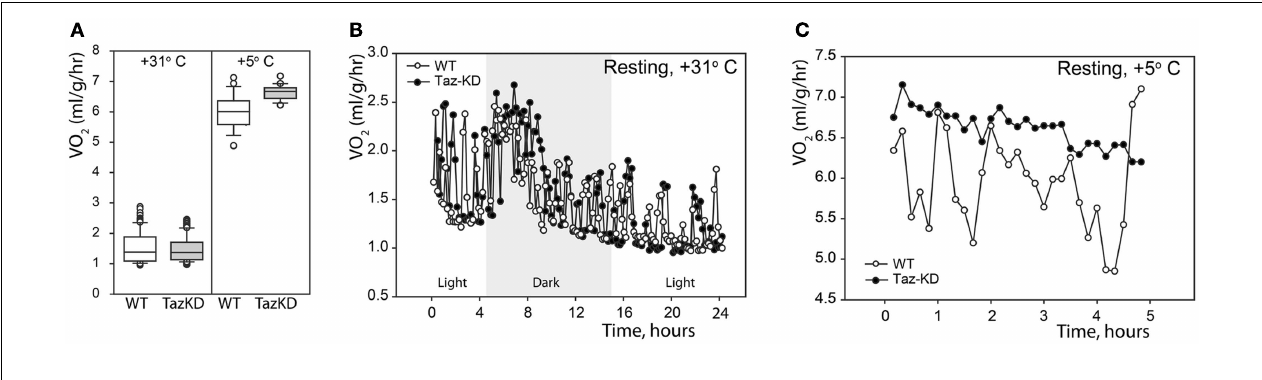
oxygen consumption ofWT andTaz-KD mice during a 24-h period at + 31˚C. Dark and light cycles are shown. (C) Representative plot of normalized oxygen consumption ofWT andTaz-KD mice during a 5-h period at +